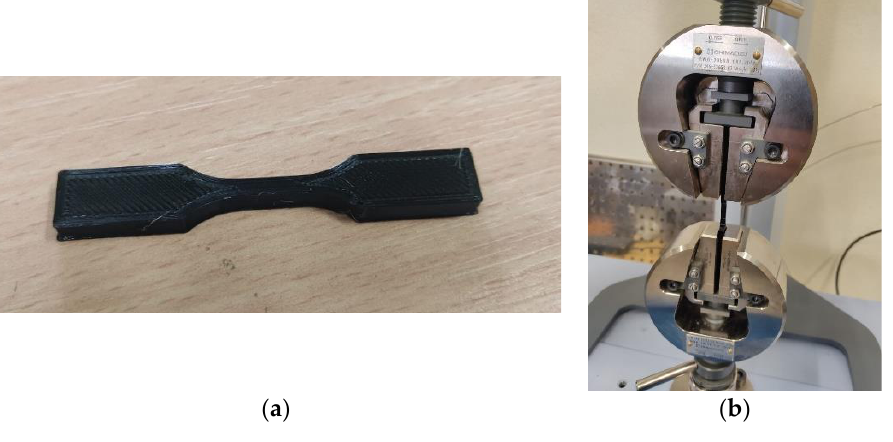
Figure 5. Tensile specimen ( a ) and tensile tests ( b ).